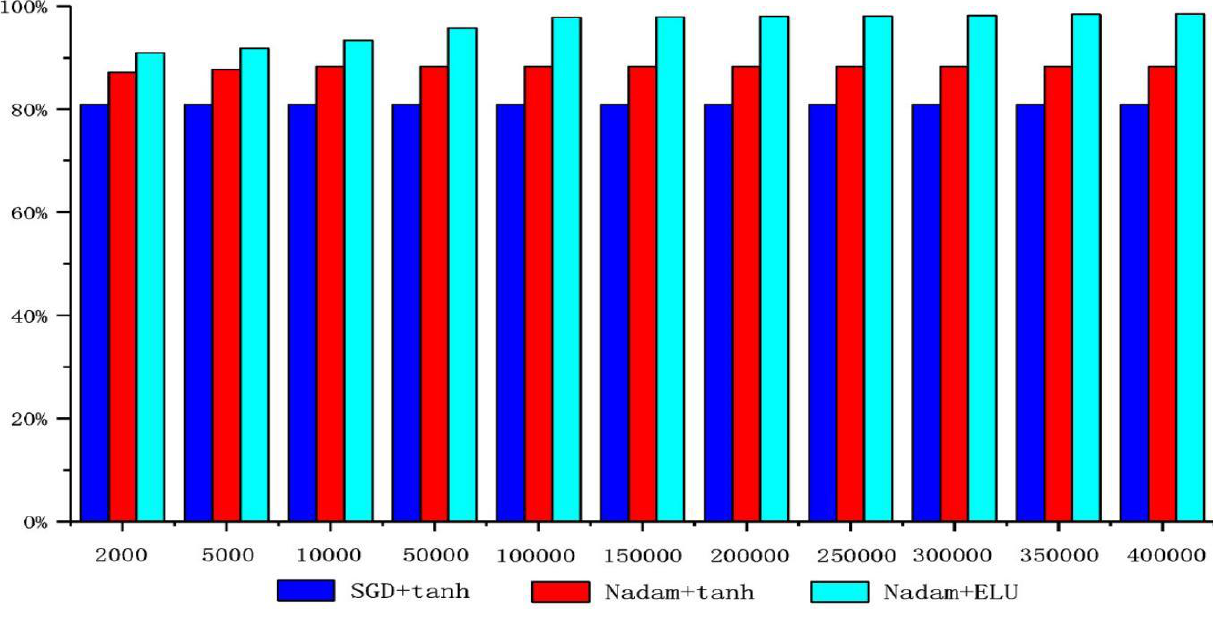
Figure 16. The solving speed comparison of the three solution methods. Table 5. The partial test results of three solution methods.